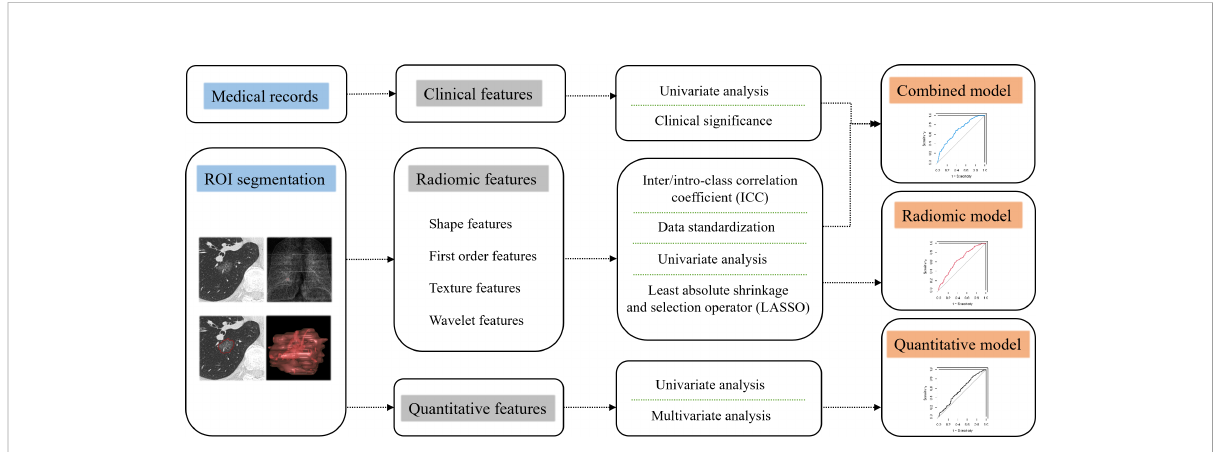
FIGURE 1 Flow charts of constructing radiomic model, combined model and quantitative